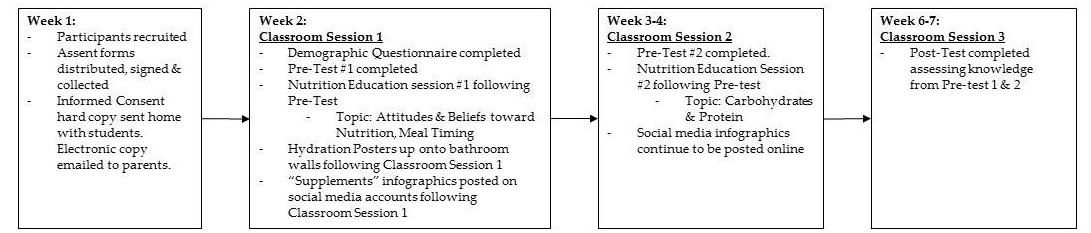
Figure 1. Timeline of events.